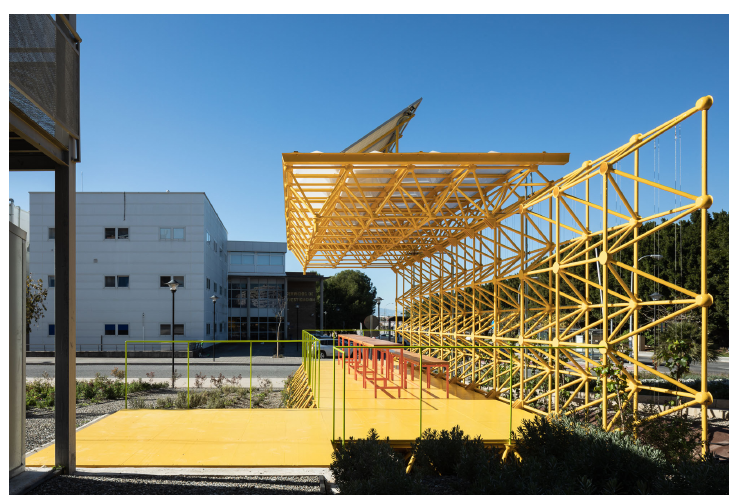
Figure 4. View of the Smart Tree area from the